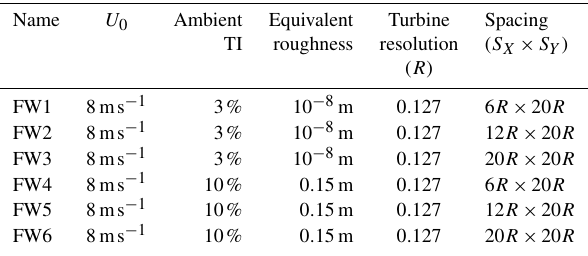
Table 4. Overview of simulations performed by FW. The simula- tions included two rows of 50 turbines and 60min of data, but only data from one row of 50 turbines are used.